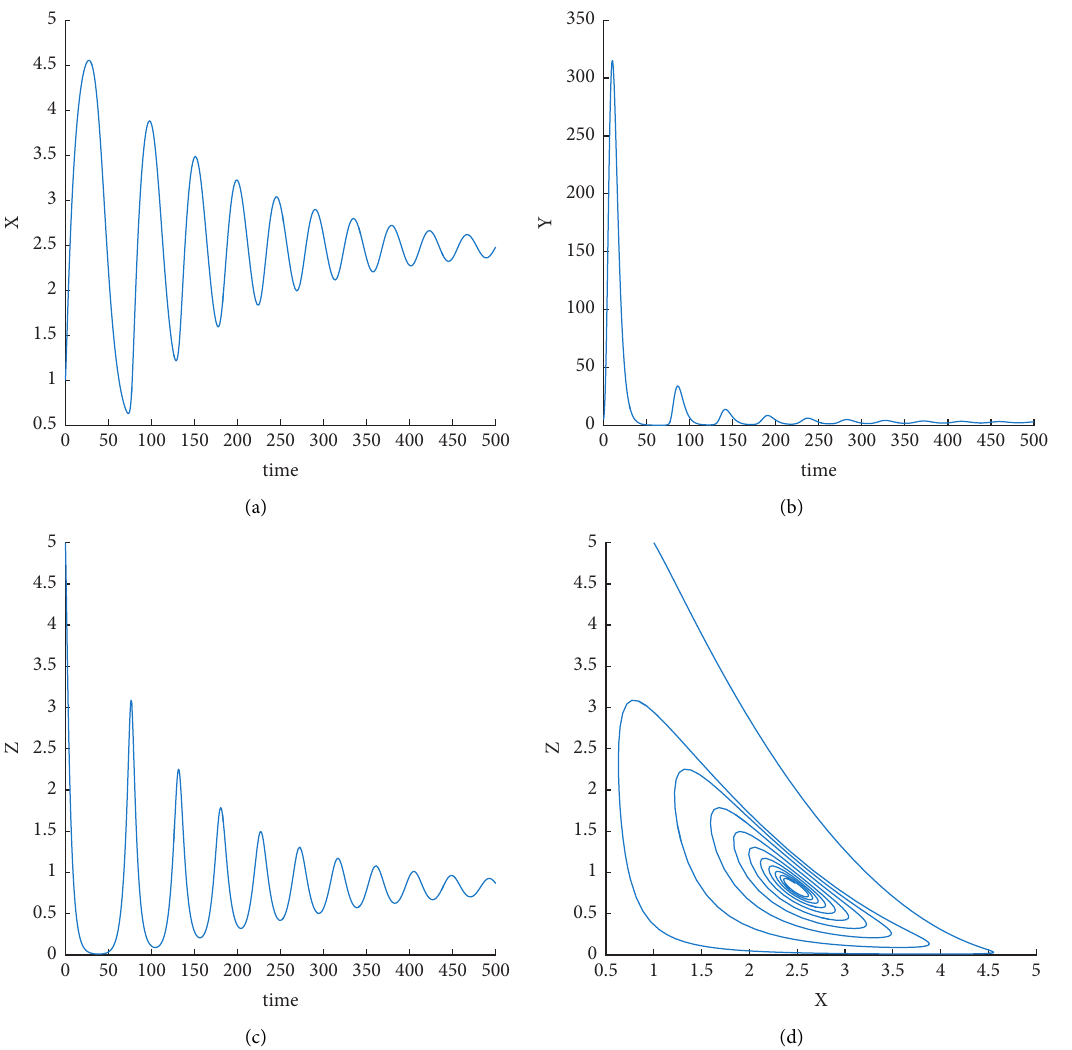
Figure 1: (a)–(d)) Dynamic of chemicals involved in bone formation process obtained through classical differential